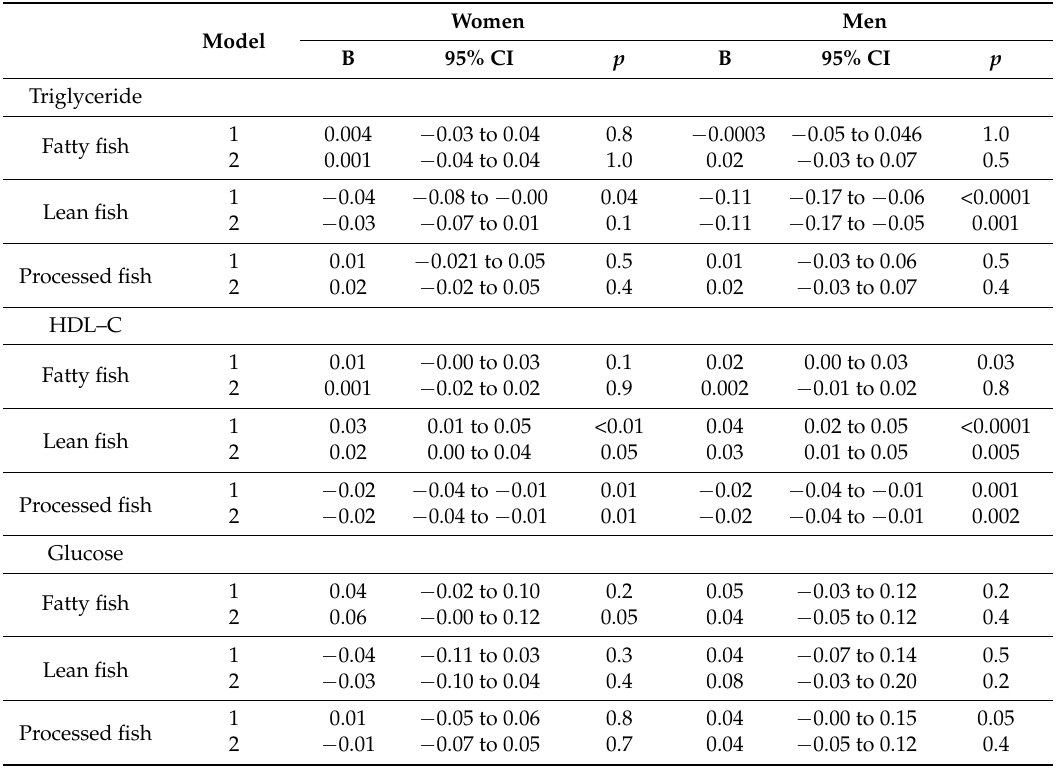
Table 7. Estimated change in triglyceride, HDL-cholesterol and blood glucose, by consumption of fish. Women Model